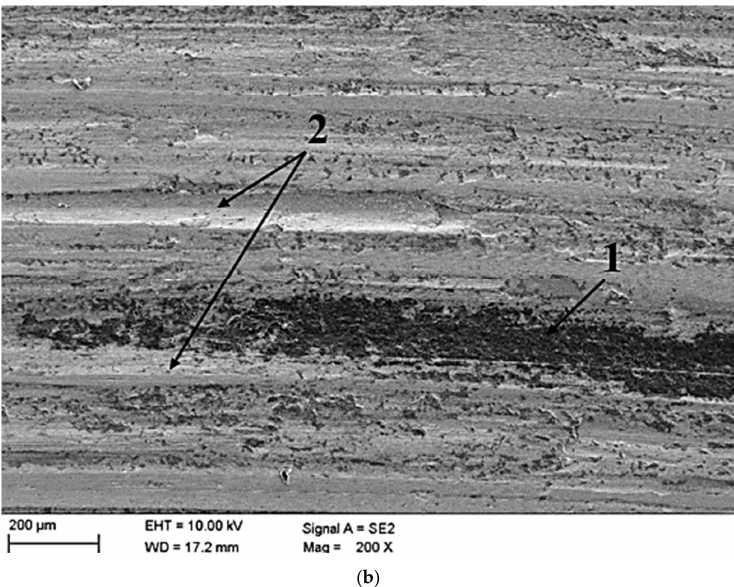
Figure 9. Steel sample surface after the wear tests; ( a ) 1—clayey abrasive with a carbon substance; 2—scratches; 3—a grain pressed into the clayey abrasives; ( b) 1—clayey abrasive with a carbon substance; 2—scratches.